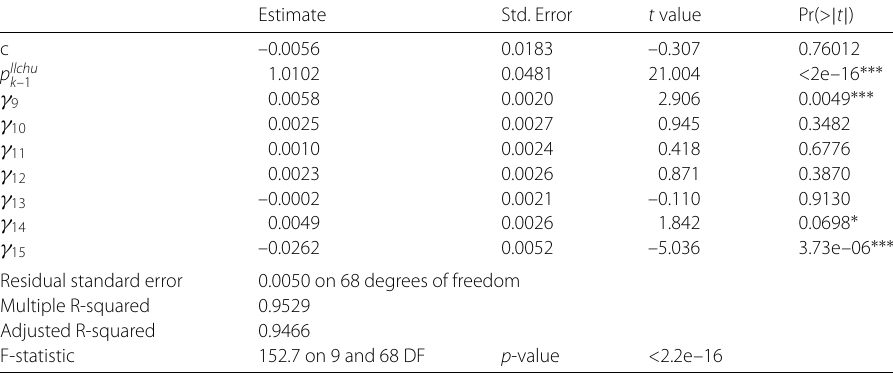
Table 3 Influential significance of events detected for Eric Chu Estimate Std. Error